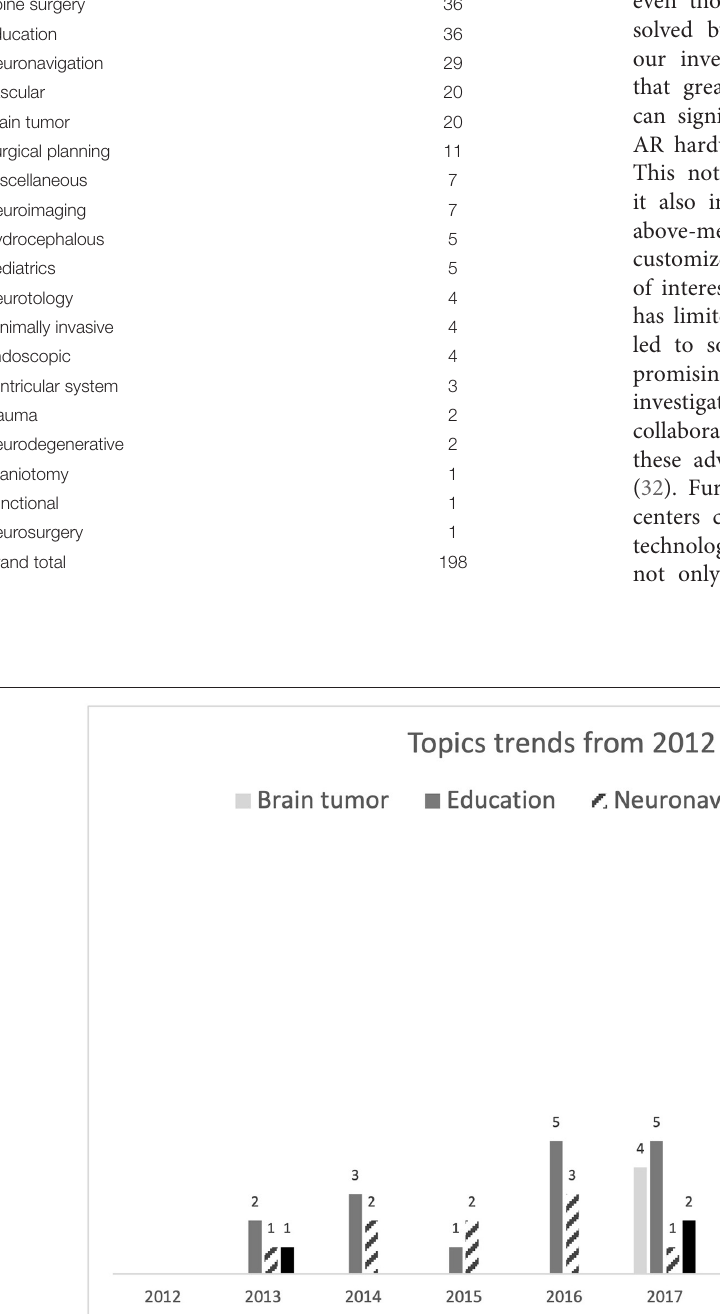
Frontiers in Surgery |